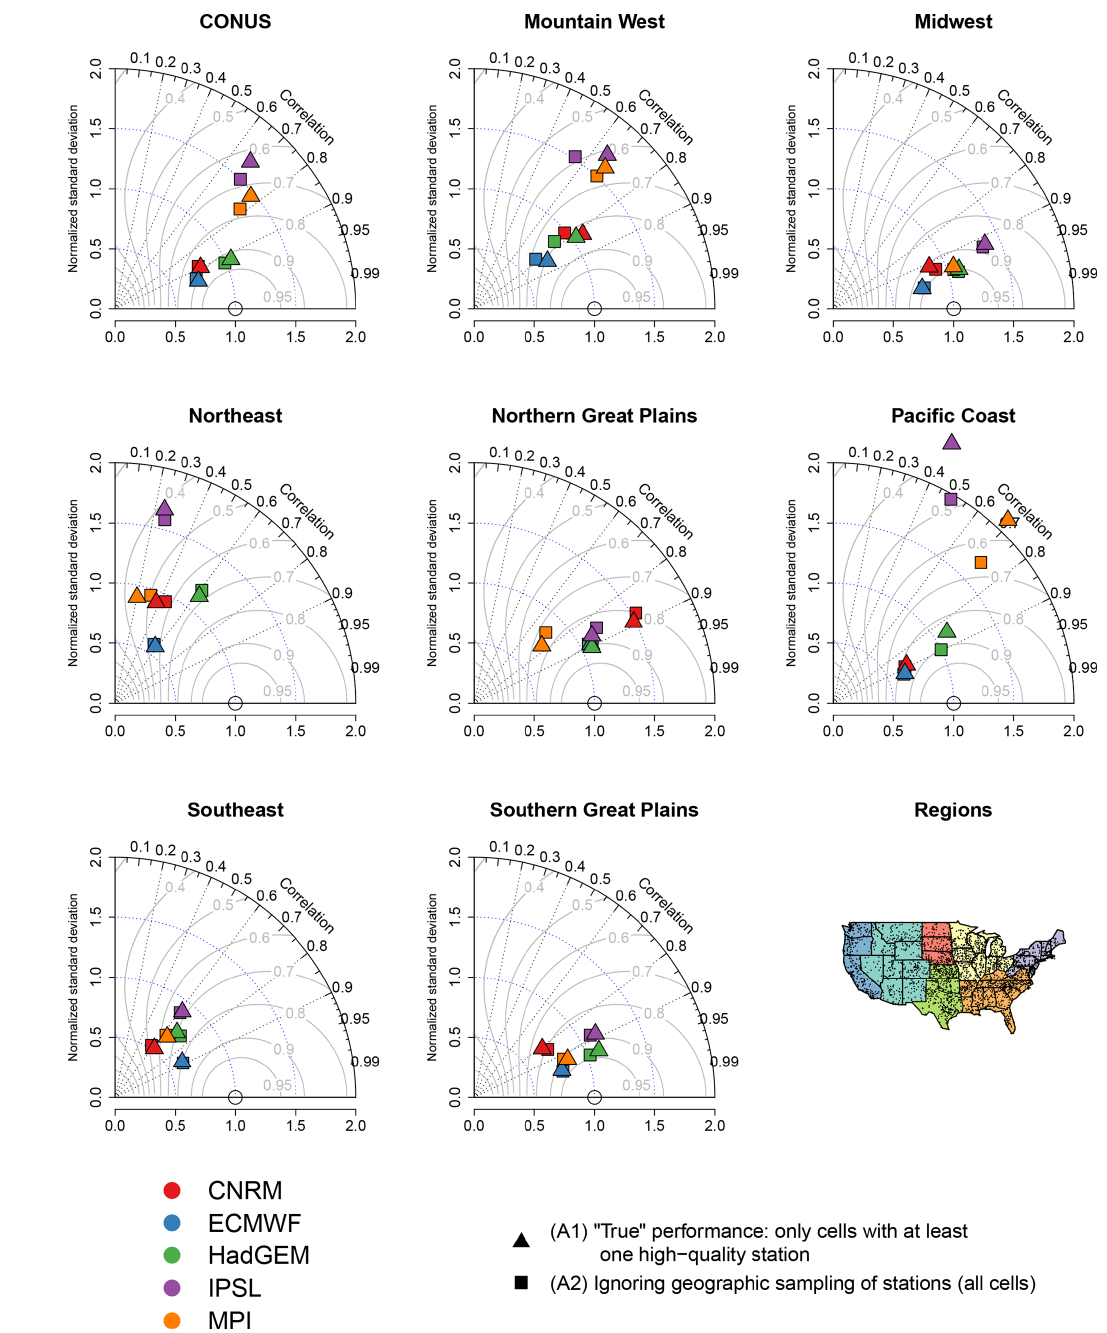
Figure 5. Taylor diagrams comparing 20-year return values for CONUS and the climate subregions for the climate models versus regridded L15. The gray curvilinear lines represent the skill score for each model relative to the regridded